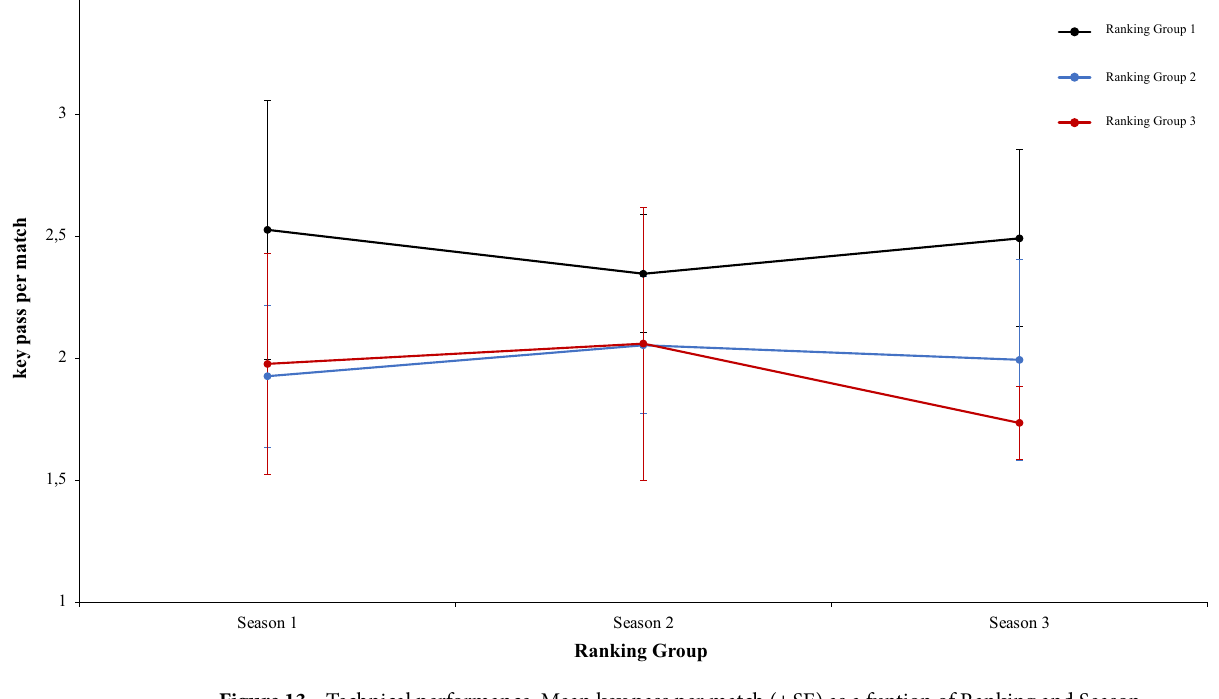
Figure 13. Technical performance. Mean key pass per match (± SE) as a funtion of Ranking and Season Condition.